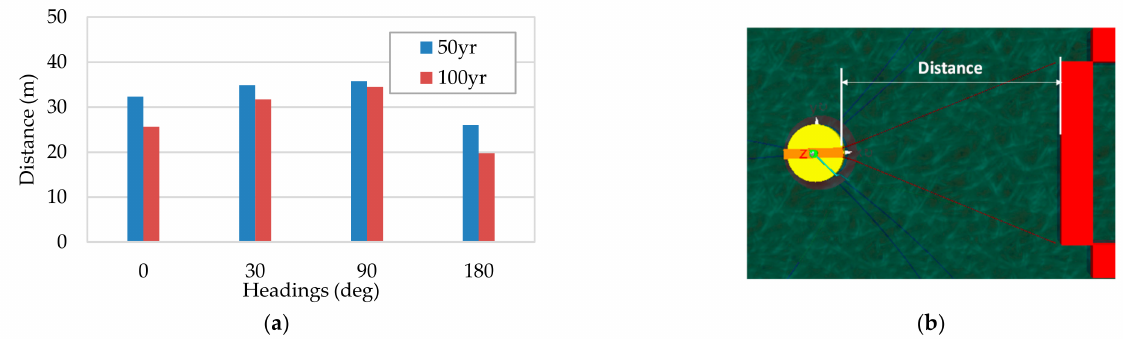
Figure 11. Distance between the mooring buoy and WEC platform: ( a ) minimum distances for the various headings under the 50 and 100 y storms; ( b ) definition of distance between two structures.